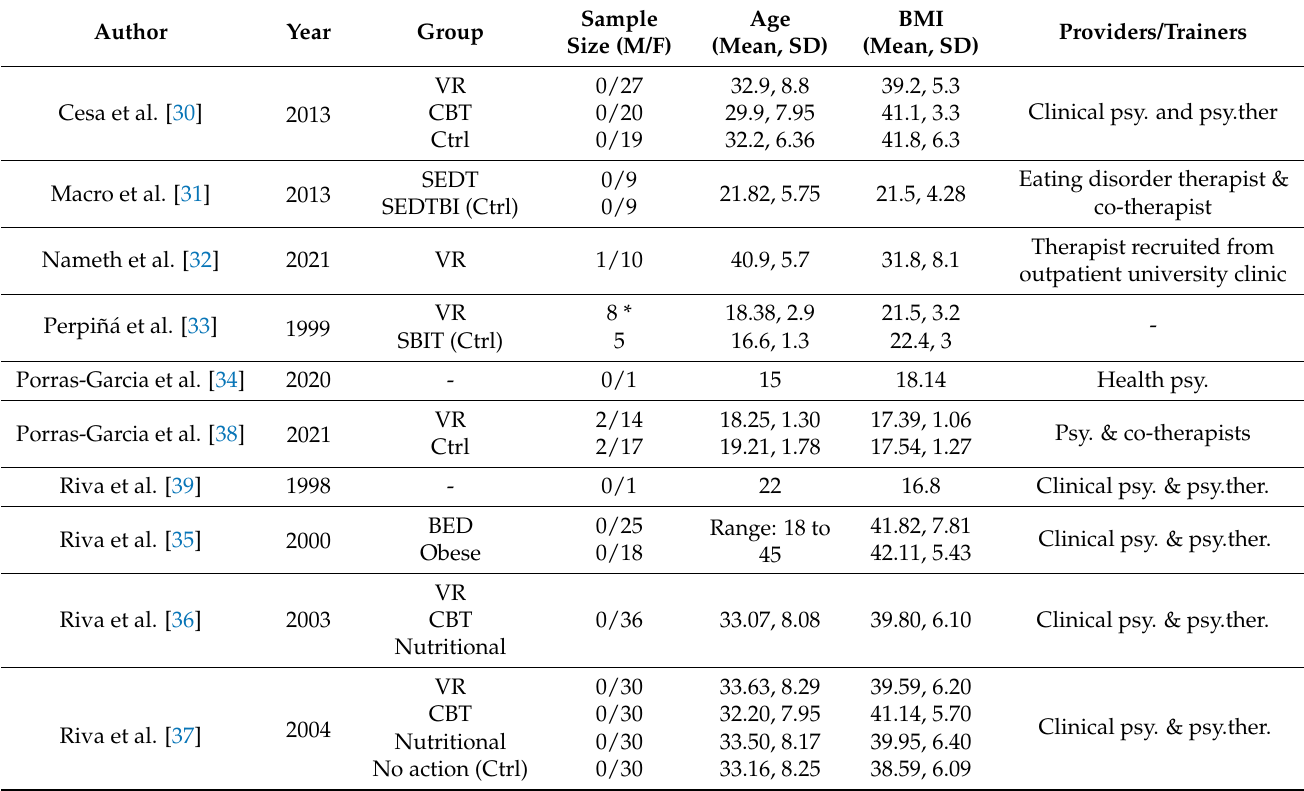
Table 2. Basic information of the recipients and providers of the reviewed